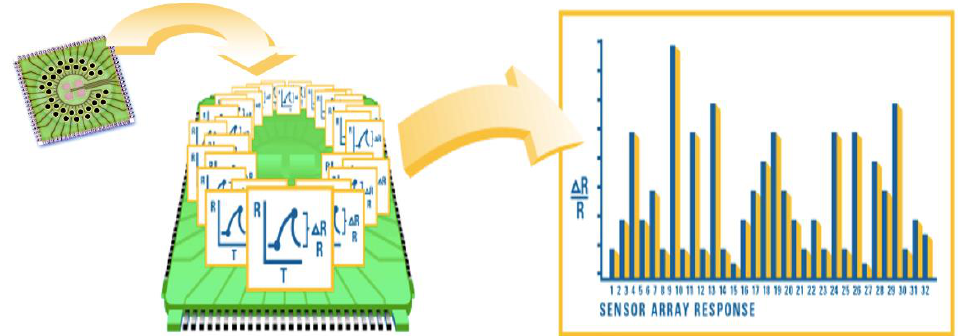
Figure 1. Working principle of Cyranose 320: it is based on a nano-composite array of 32 organic polymer sensors. If exposed to VOC combinations, the polymers swell, thereby modifying their electrical resistance. Raw data are registered as the increase in resistance of any single sensors and the combination of all signals results in a “breathprint”.